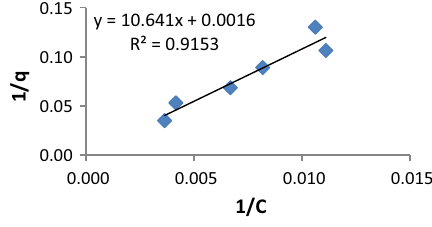
Fig. 9 Langmuir adsorption isotherm of spent tea